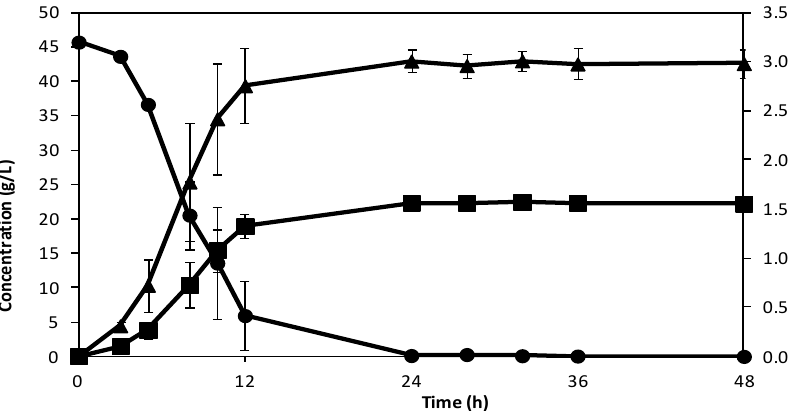
Figure 3. Concentration of sucrose (●) and ethanol (■) on the primary axis, and glycerol (▲) on the secondary axis with time, at 30 °C without mixing.